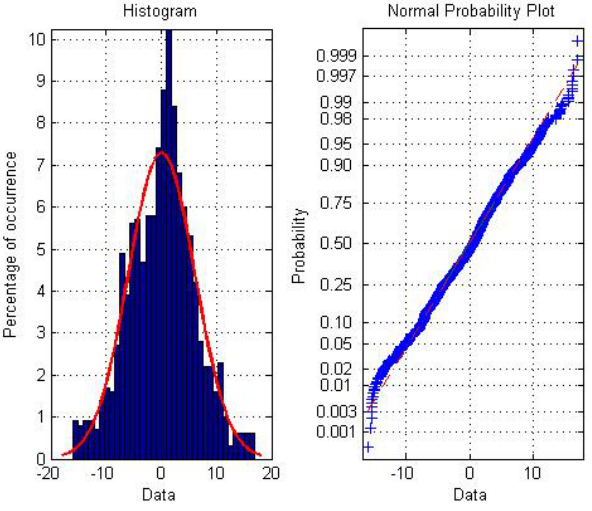
Figure 4. A testing of the Normal distribution hypothesis . Fig. 4. A testing of the normal distribution